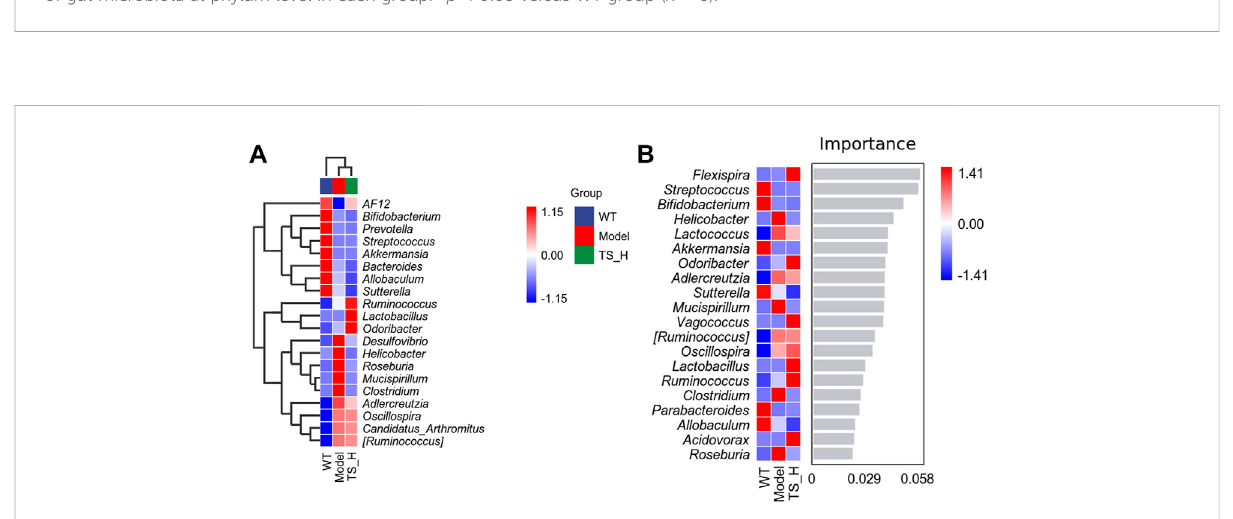
FIGURE 12 Heatmaps of most differentially abundant taxa in WT mice, APP/PS1 mice and TS treatment APP/PS1 mice. (A) Heat-map of microbial community composition. (B) Random forest analysis map. n = 5 for each treatment.